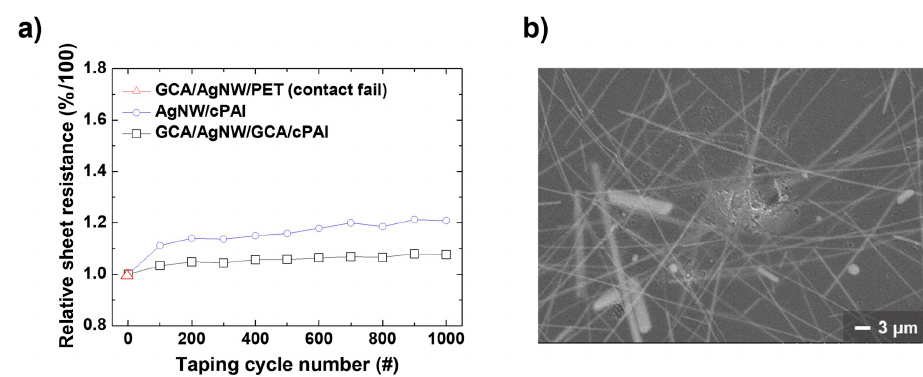
Figure 7. ( a ) Taping test of the GCA/AgNW/PET, AgNW/cPAI, and GCA/AgNW/GCA/cPAI-embedded electrodes, ( b ) SEM image after taping (1000 times) of the GCA/AgNW/GCA/cPAI-embedded electrode.